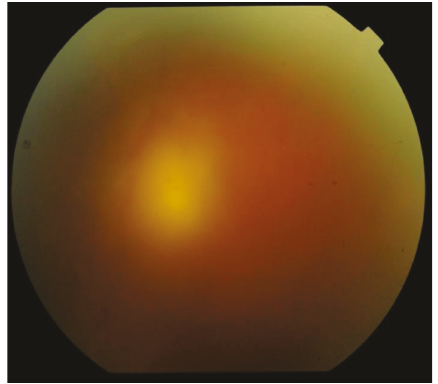
Figure 2: Group II